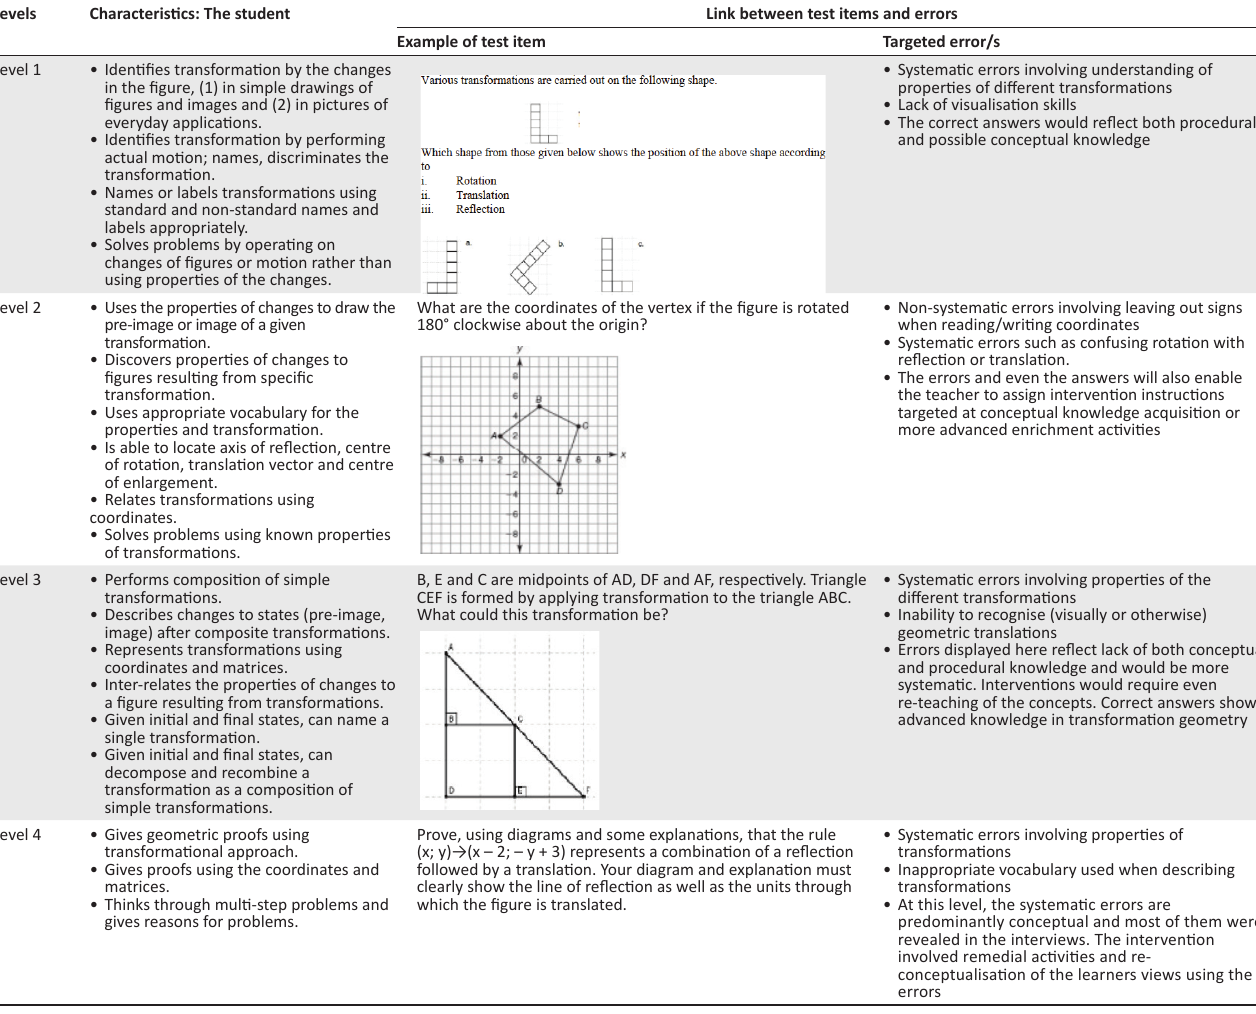
TABLE 1: Soon’s levels and the link between test items and foundation phase teachers’ challenges with transformation geometry.